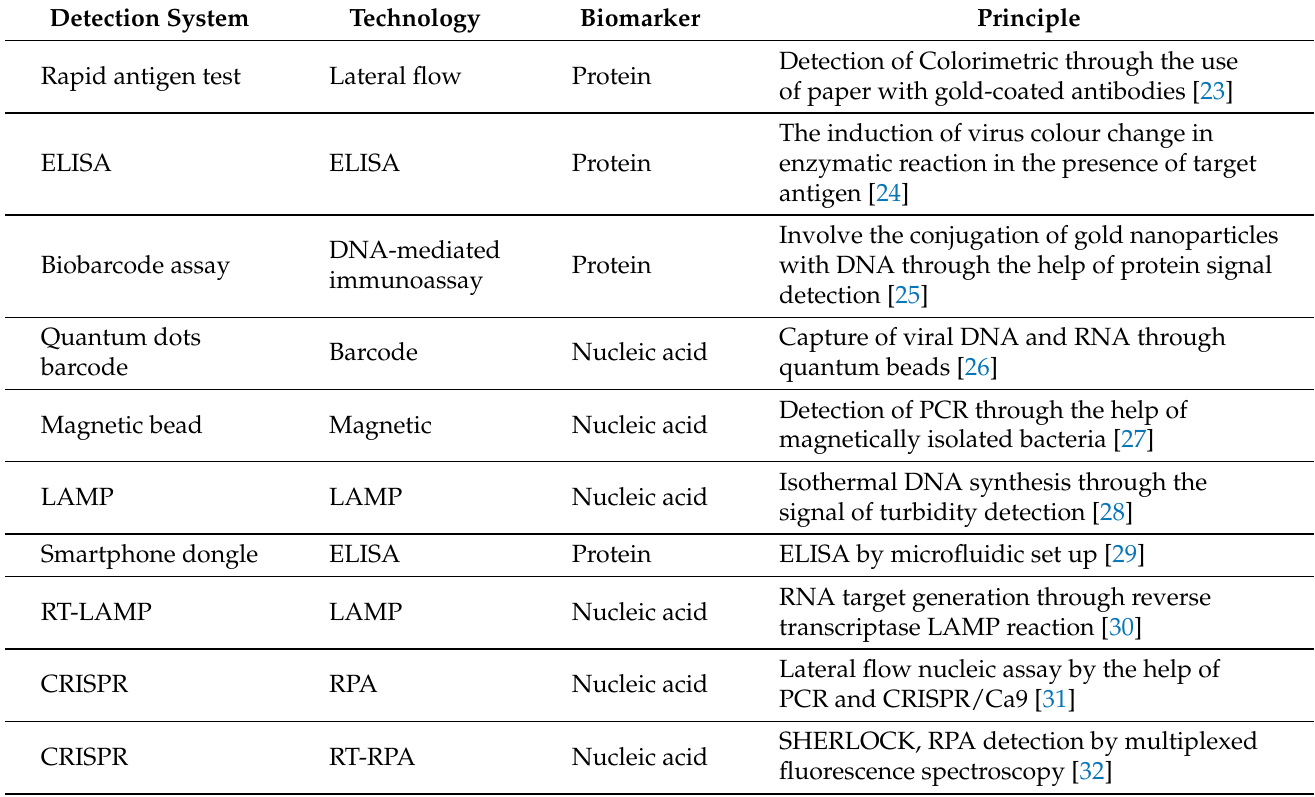
Figure 1. The diagram depicts four pipeline for diagnostics technologies development. In most cases, stages 1 and 2 are designed and achieved by researchers while stages 3 and 4 typically involve commercial transfer to companies. Table 1. Notable developed and emerging diagnostics